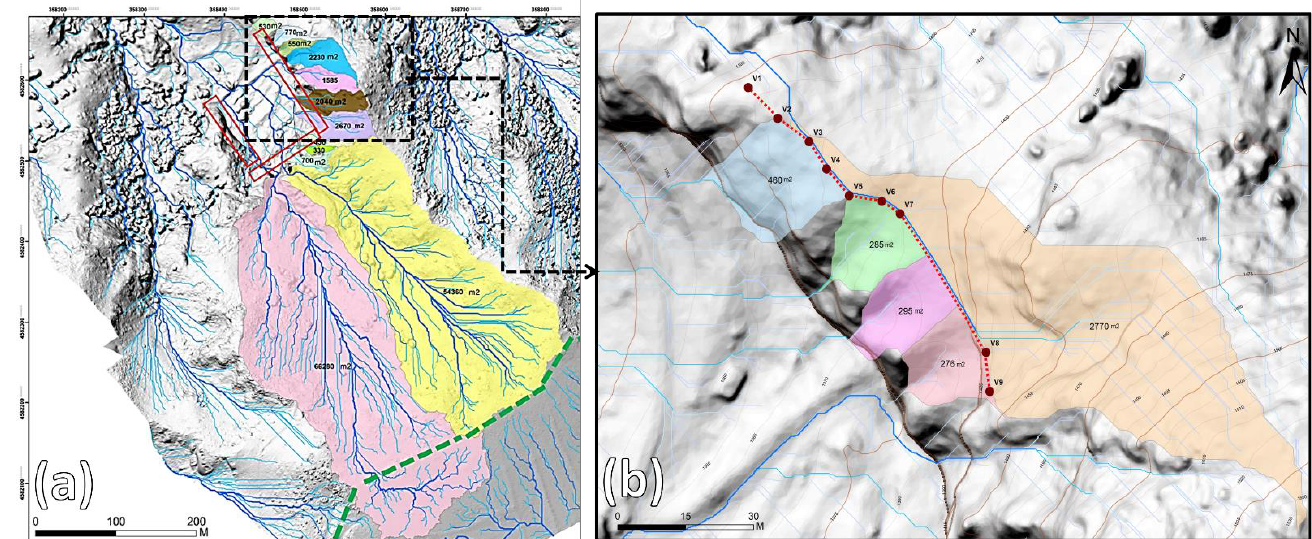
Figure 18. Vanis Kvabebi mitigation measures: hydrographic model ( a ) showing the watershed surfaces, the rock cliff areas (red rectangles), the area where the water drainage system (shown in b ) is planned (dashed black square), and the Javakheti Plateau divide (dashed green line), (map of the planned water diverting wall (dashed red line) ( b ).